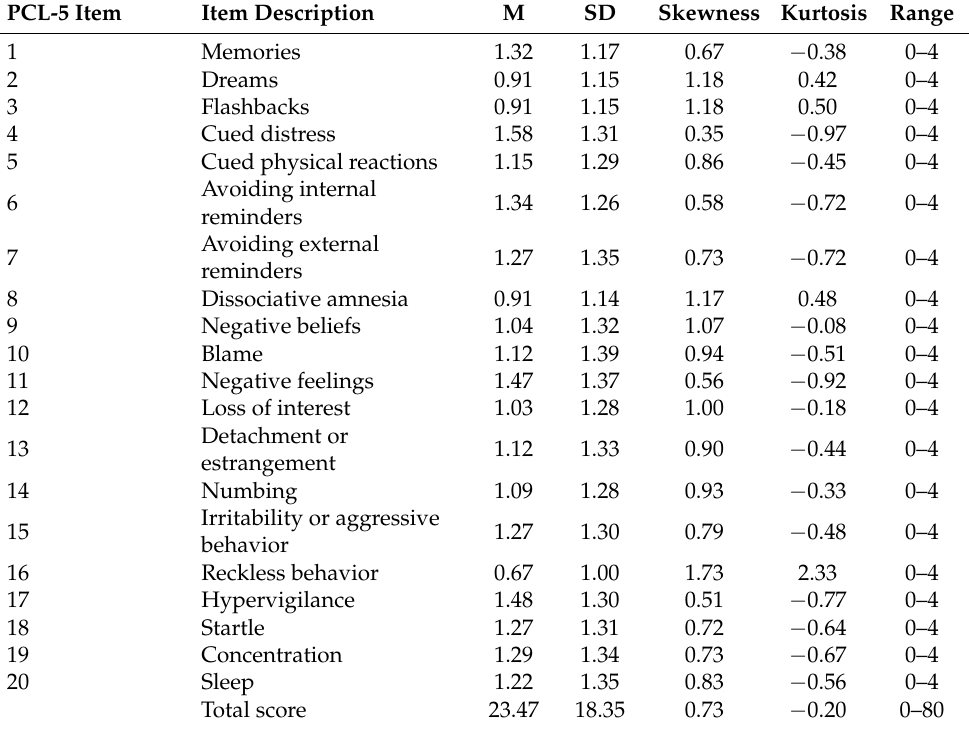
Table 2. PCL-5 descriptive statistics.